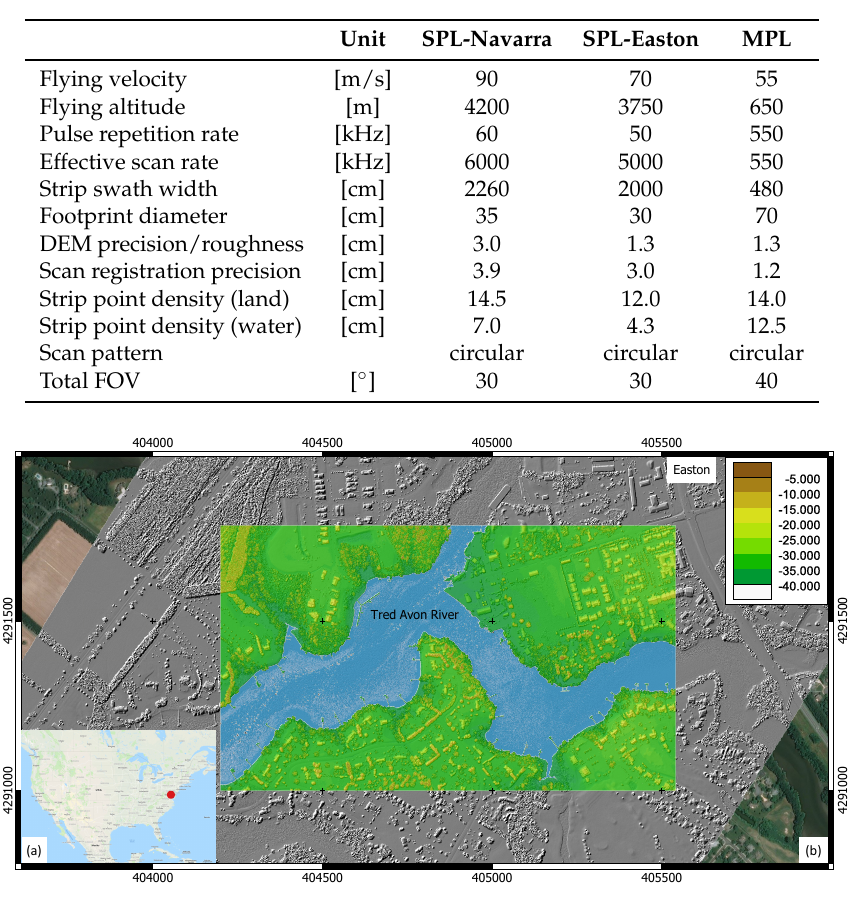
Figure 4. Single Photon LiDAR area Easton, MD, USA; ( a ) shaded relief map of flight strip 3 on top of Google Bing orthophoto, coordinate reference frame: WGS 84, UTM 18N, ellipsoid heights, units = meters; center: analysis area, combination of shaded relief and color-coded height map; ( b ) overview map of the USA (source: USGS), red circle: location of study